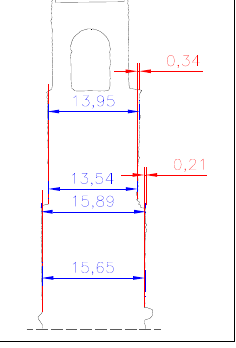
Figure 6. Transversal section of pile 4 (values in meters).